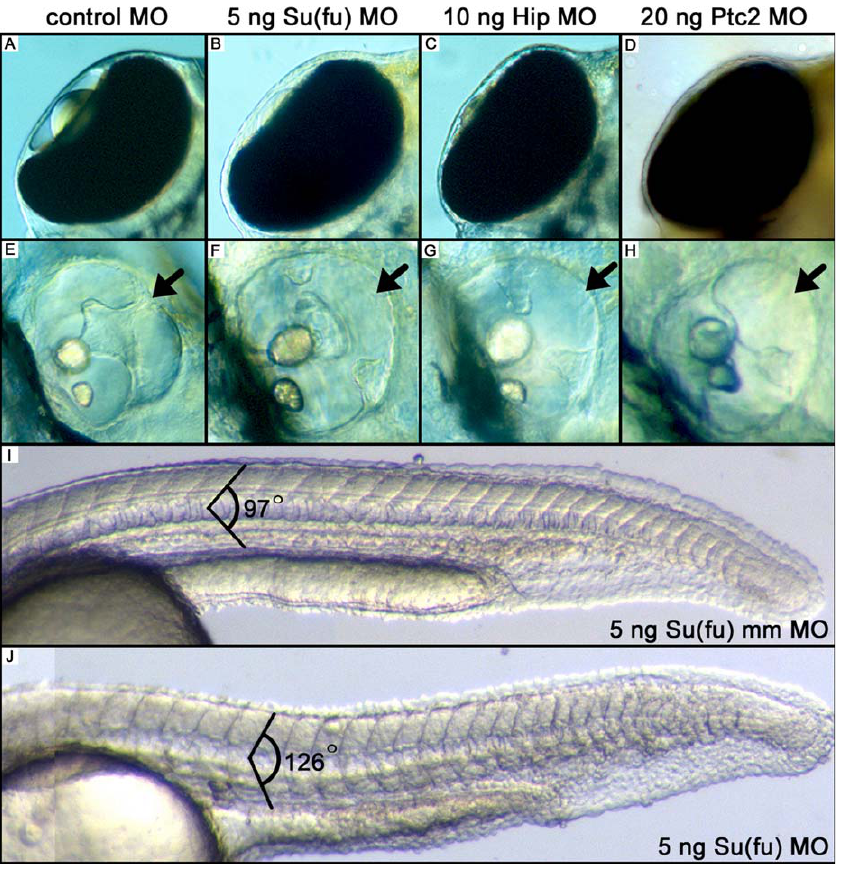
Figure 5. MO Injection Experiments against Su(fu), Hip, and Ptc2 (A) Dorsal view of the eye showing the lens in the eye chamber. (B–D) Dorsal view of embryos injected with the indicated MOs, resulting in a phenocopy of dre, uki, and lep mutants. (E) A wild-type ear showing the presence of the dorsolateral septum (arrow), which is not present after injections with the indicated MOs (F–H, arrow). (I) Injections with control MOs against the initiation codon of Su(fu) results in chevron-shaped somites with an angle of 97 8 . (J) Injection of MOs against Su(fu) results in a more obtuse angle of the somite (126 8 ). DOI: